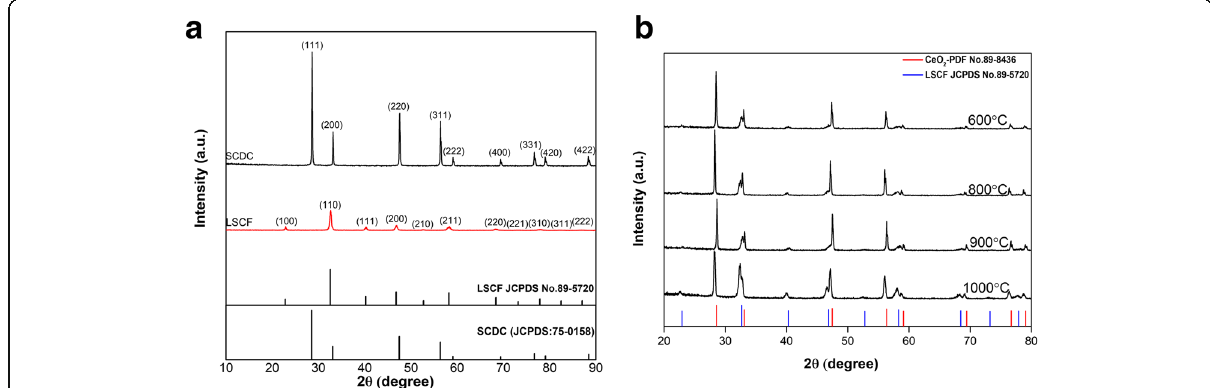
Fig. 1 a The XRD patterns of SCDC and LSCF and their corresponding PDF card. b LSCF-SCDC samples sintered at different temperatures and pure CeO2 PDF card